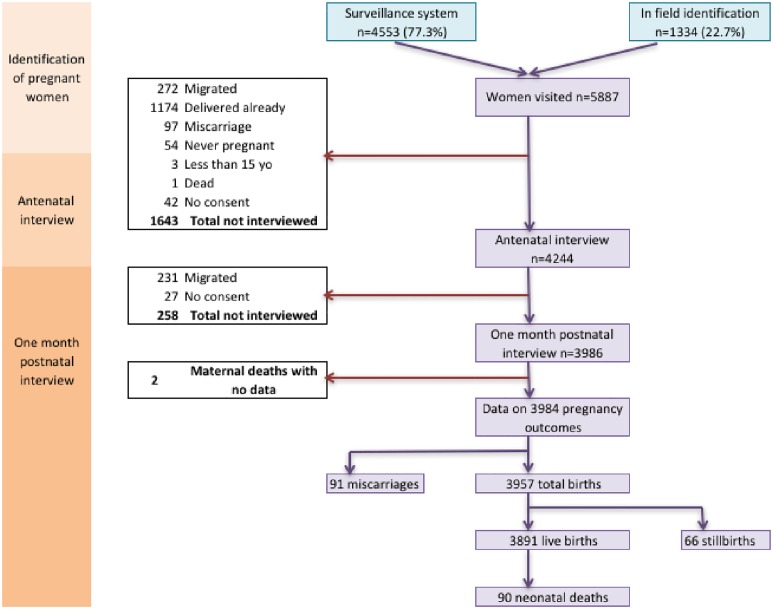
Case flow and outcomes for women recruited and followed up.